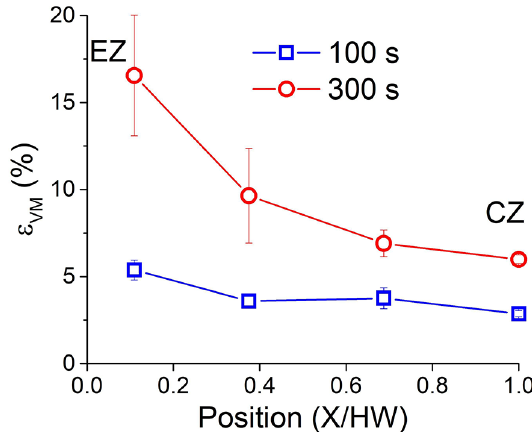
Figure 5. von Mises equivalent strain calculated for each zone - X represents the position relative to the edge of the